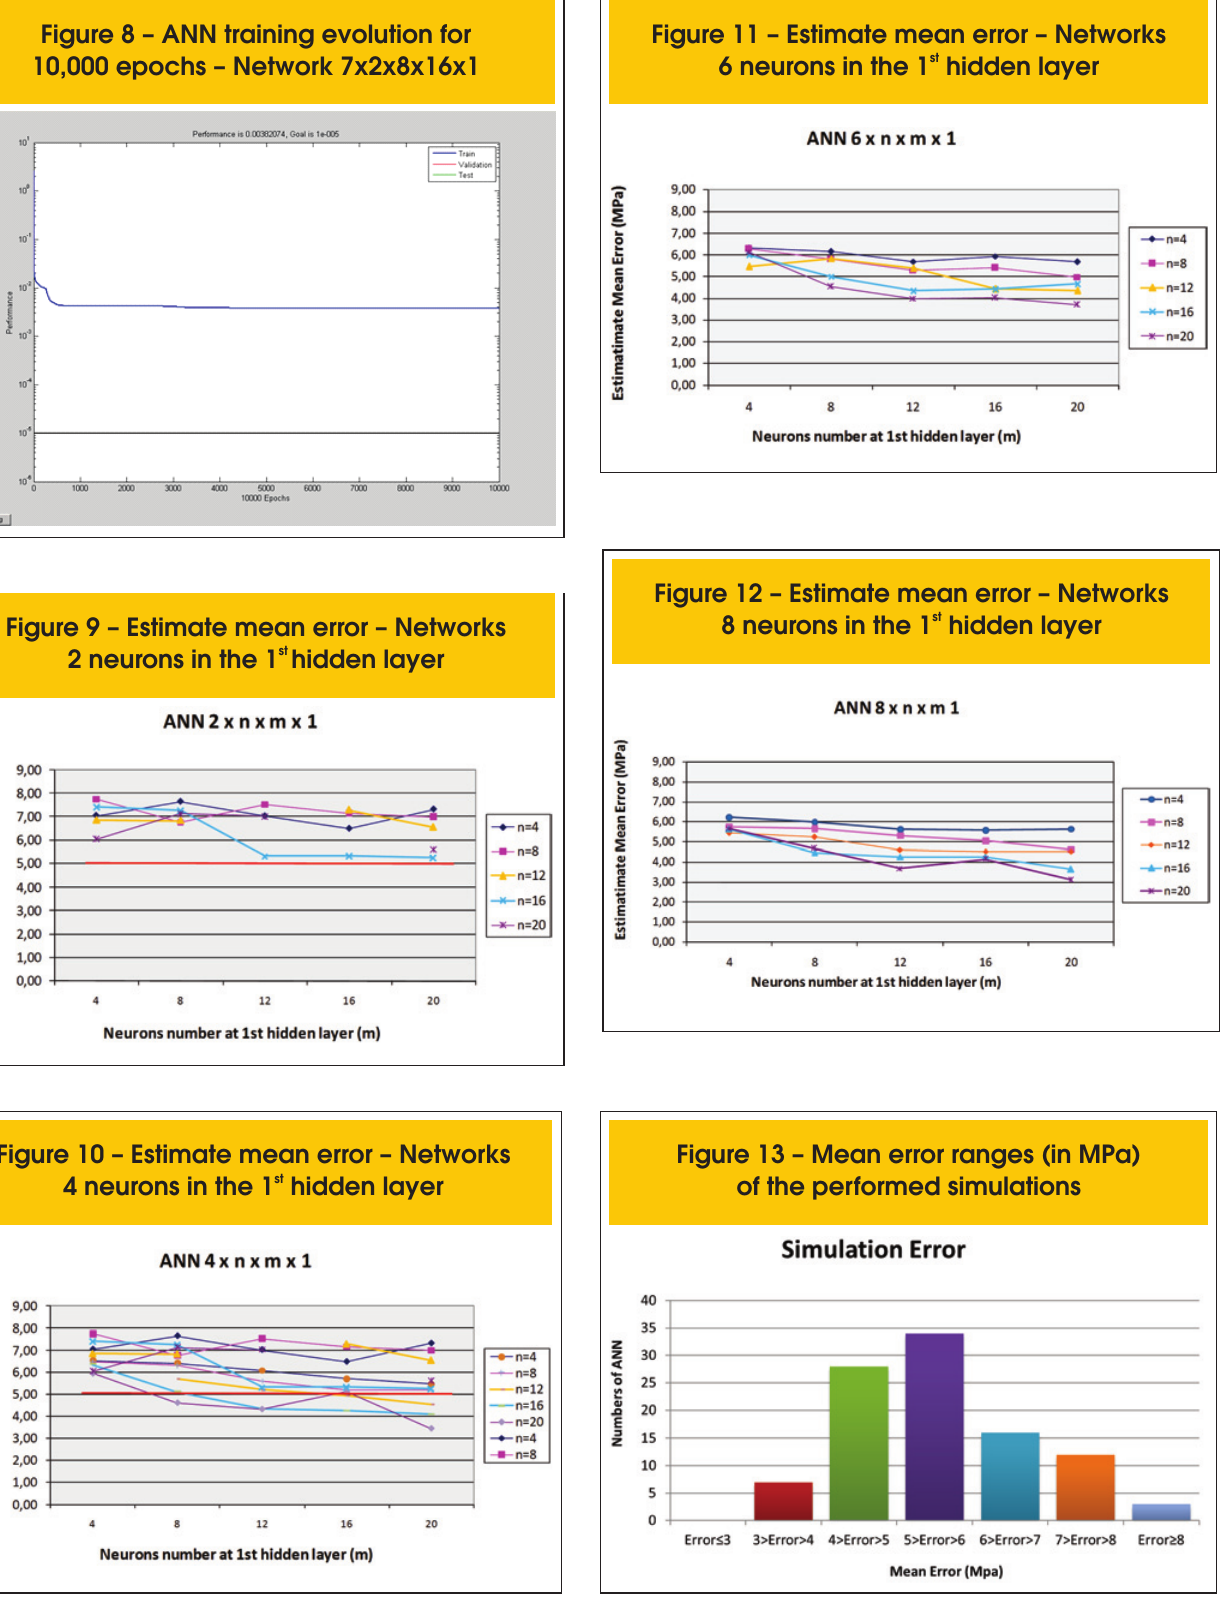
Figure 8 – ANN training evolution for 10,000 epochs – Network 7x2x8x16x1